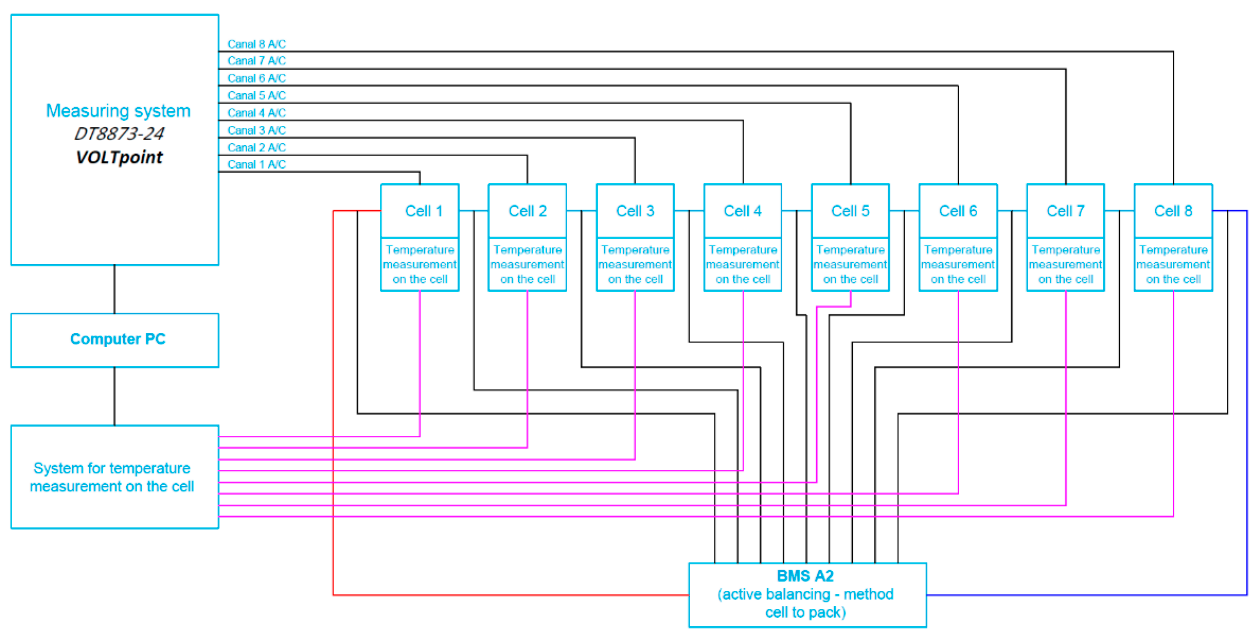
Figure 7. Block diagram of the cell measurement system for the battery with connected BMS with active balancing, the cell-to-battery method.